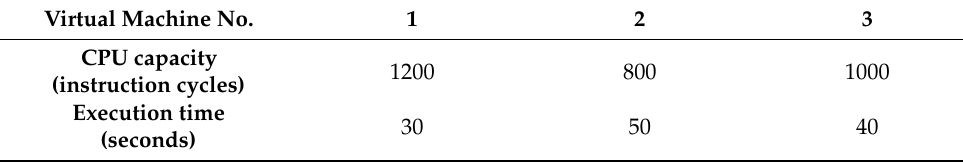
Table 3. Configuration of 3 virtual machines for scenario 1.